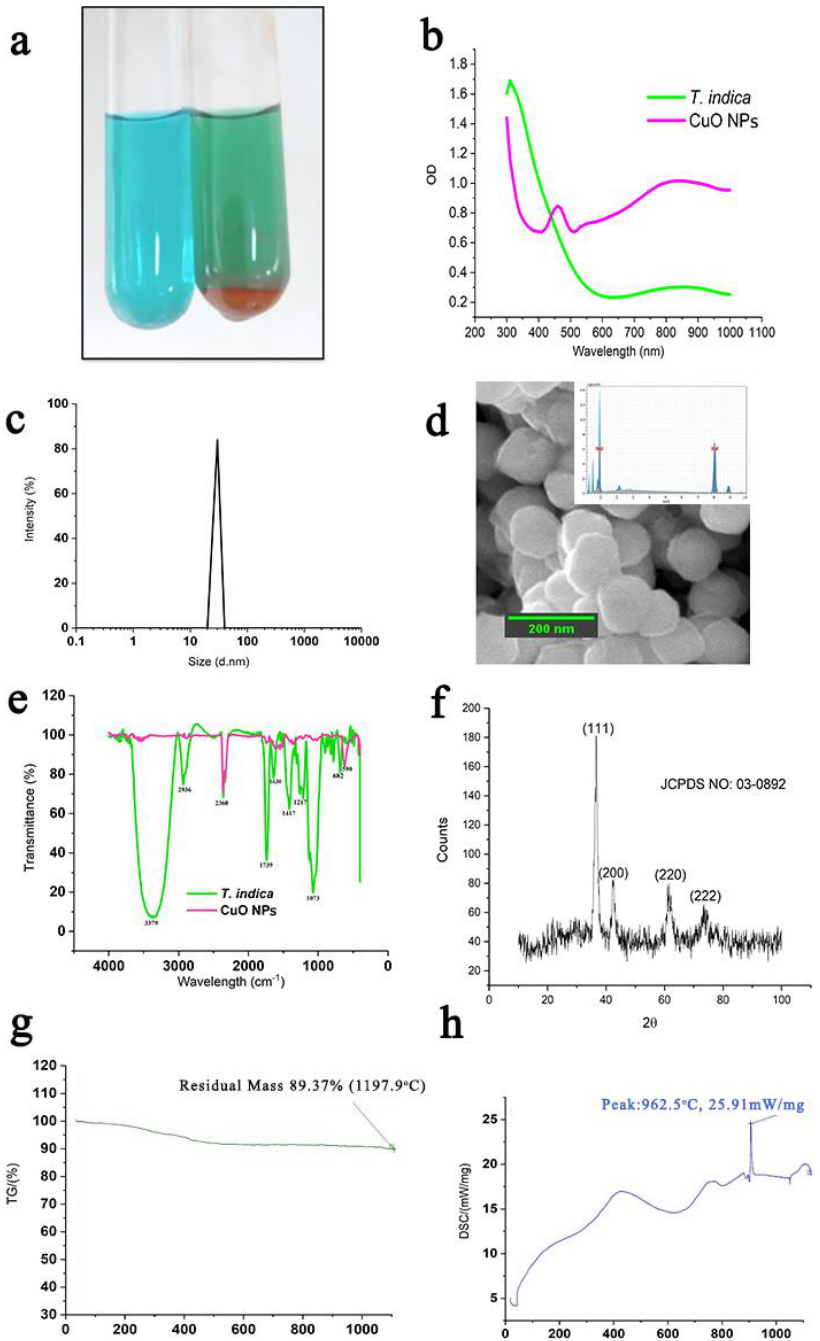
Figure 2. Synthesis and characterization of CuO NPs. ( a ) Formation of CuO NPs; ( b ) UV-Vis spectrum; ( c ) particle size distribution; ( d ) field emission scanning electron microscopic image (FESEM); ( e ) Fourier-transformed infrared spectrum (FTIR); ( f ) X-ray diffraction (XRD); ( g ) differential scanning calorimetry (DSC); ( h ) thermo gravimetric analysis (TGA).